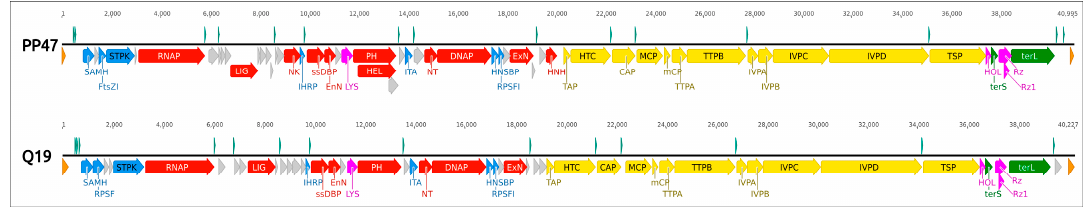
Figure 7. Genetic map of phages PP47 and Q19. The colors of different functional modules are as follows: yellow, morphogenesis; red, replication, transcription and nucleic acids processing; green, packaging; purple, lysis proteins; blue, regulation of host defense and metabolic processes; orange, terminal repeats; grey, hypothetical proteins. Putative transcriptional promoters, predicted with Phage Promoters, are shown above each sequence (presented as a black line) and colored cyan. Numbers above the sequences show the position in genomes. Genes’ names are as follows: SAMH, S-adenosyl-L-methionine hydrolase; RPSF, RNA polymerase σ 54 factor; FtsZI, cell division FtsZ inhibitor; STPK, seryl-threonyl protein kinase; RNAP, DNA-directed RNA polymerase; LIG, DNA ligase; NK, nucleotide kinase; IHRP, inhibitor of host bacterial RNA polymerase; ssDBP, ssDNA-binding protein CDS; EnN, endonuclease I; LYS, lysozyme, N-acetylmuramoyl-L-alanine amidase; PH, DNA primase / helicase; HEL, DNA helicase; ITA, inhibitor of toxin / antitoxin system; NT, nucleotidyltransferase; DNAP, DNA polymerase; HNSBP, H-NS and tRNA binding protein CDS; RPSFI, host RNA polymerase σ 70 factor inhibitor; ExN, 5 (cid:48) -3 (cid:48) exonuclease; HNH, HNH endonuclease; TAP, tail assembly protein; HTC, head-tail connector protein; CAP, capsid assembly protein; MCP, major capsid protein; mCP, minor capsid protein; TTPA, tail tubular protein A; TTPB, tail tubular protein B; IVPA, internal virion protein A; IVPB, internal virion protein